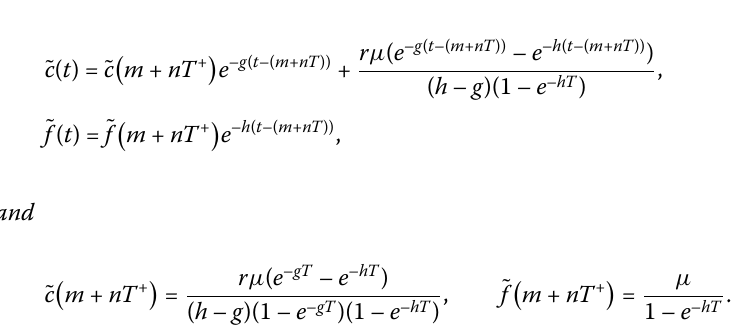
˜ f ( t ) → f ( t ) as t → ∞ , where t ∈ ( m + nT , m + ( n + 1) T ), n = 0,1,..., q – 1, m ∈ N